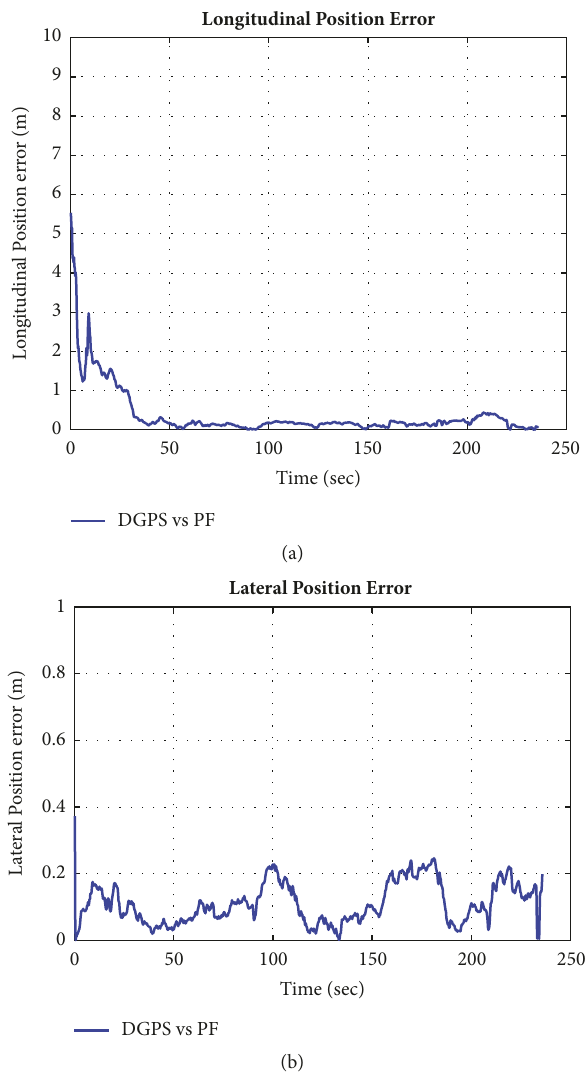
Figure 10: Root mean square error between the position estimated using our proposed method and that obtained by the DGPS: (a) the longitudinal position error and (b) the lateral position error.